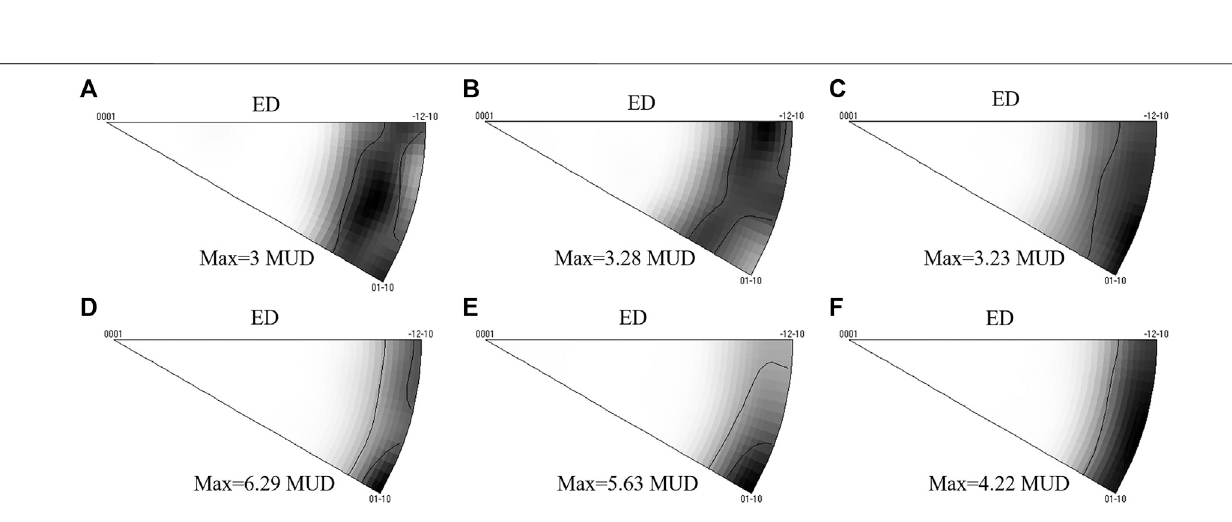
can be clearly seen inside the dimples in most alloys, except pure Mg and Mg-1Bi, indicating that these particles are probably the source of fracture. The average size of exposed particles is estimated to be ∼ 0.27, 0.54, 0.62, and